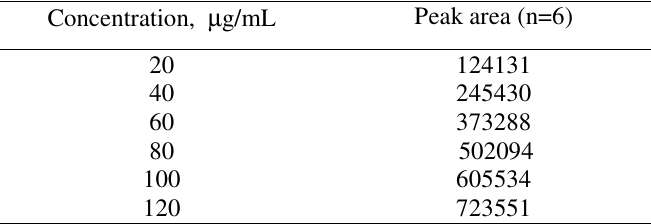
Figure 2. Typical chromatogram of quetiapine Table 1. Calibration data of the method